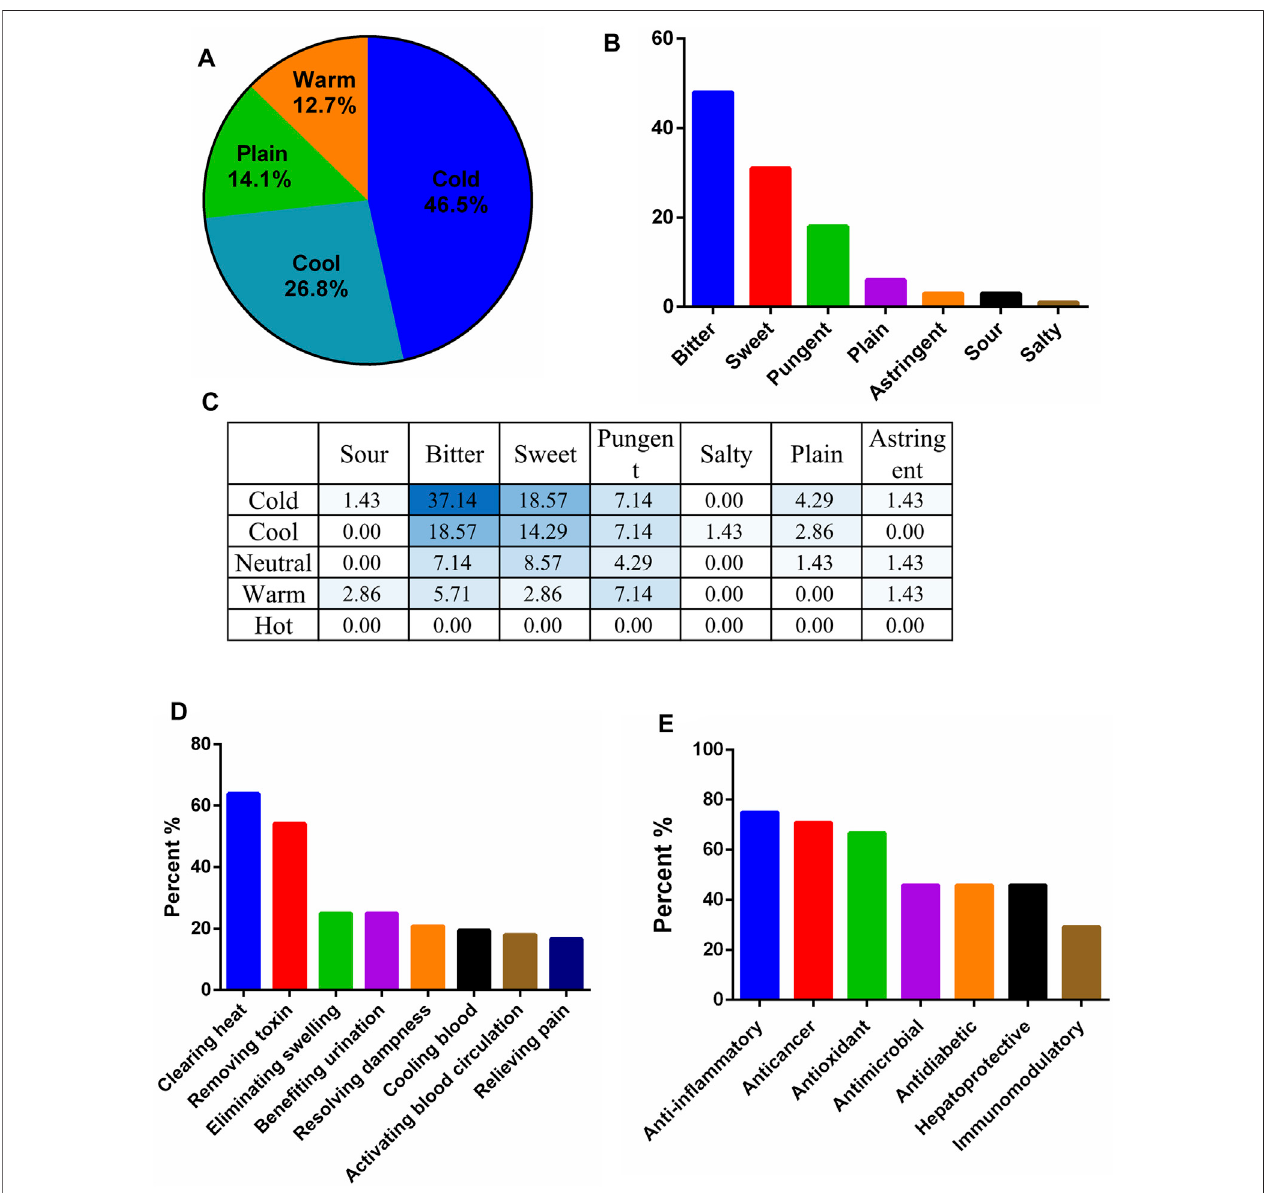
FIGURE 3 | Traditional and modern pharmacological analysis of plant materials used in Taiwanese bitter tea. (A) Nature; (B) fl avor; (C) comprehensive analysis of nature and fl avor (%); (D) ethnomedicinal effects; (E) modern pharmacological applications of plant materials with a frequency greater than nine.